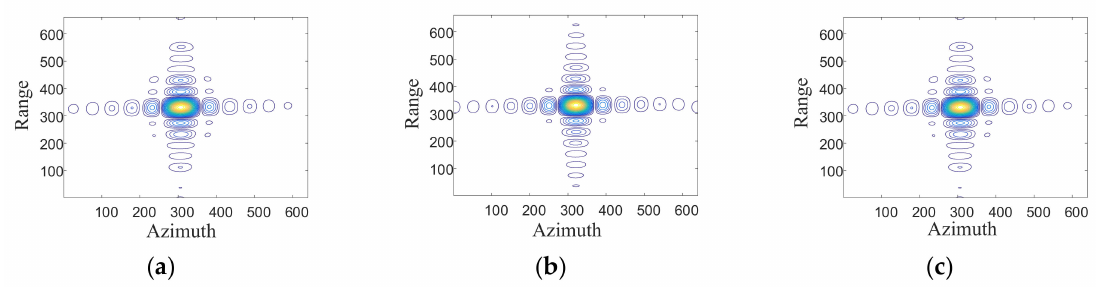
Figure 10. Contour plots of three of point targets. ( a ) contour plot of P 1 ( b ) contour plot of P 2 ; ( c ) contour plot of P 3